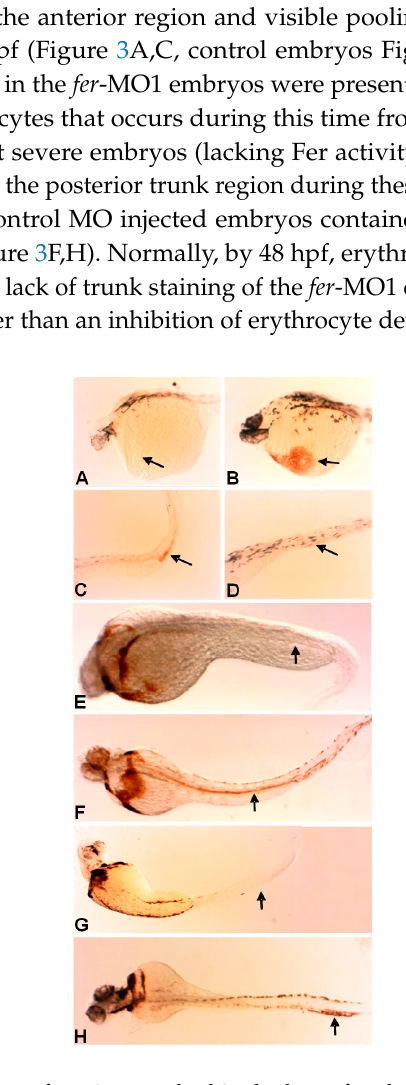
Figure 3. The loss of Fer kinase function resulted in the loss of early anterior erythrocyte formation and the loss of circulation. o-Dianisidine staining showed the slightly higher levels of erythrocyte heme groups in the posterior trunk region of fer -MO1 embryos at 30 somites (~28 hpf) ( C , control- D ), but not in the anterior ( A ), as is observed in control embryos ( B ). The staining was no longer present indicating that later erythrocyte production is functional but no circulation is taking place (control F and H , 48 and 72 hpf